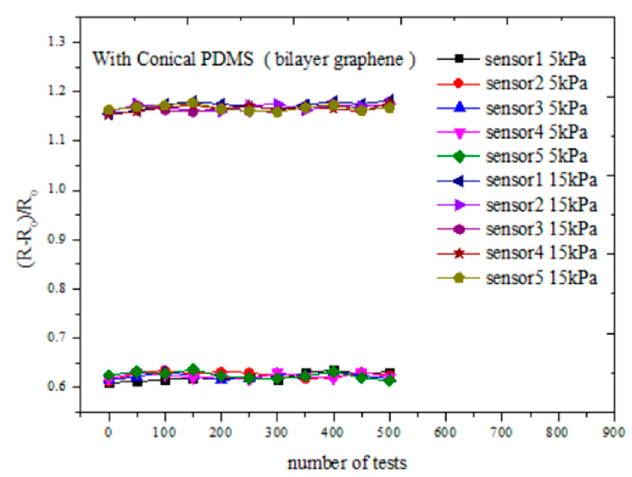
Figure 9. Sensor reproducibility test curves of conical microstructure PDMS (bilayer graphene) at 5 and 15 kPa, respectively. The dimensions of the conical microstructures PDMS are the same as in Figure 8.